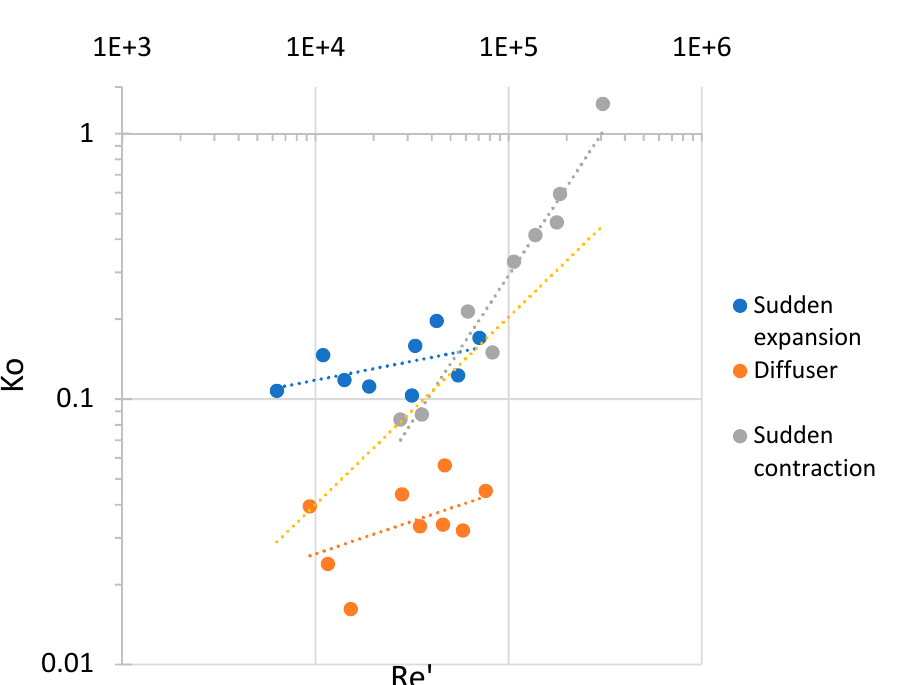
(cid:48) ) for the considered Figure 8. Correlations Ko(Re’) for the considered geometries. Figure 8. Correlations Ko ( Re